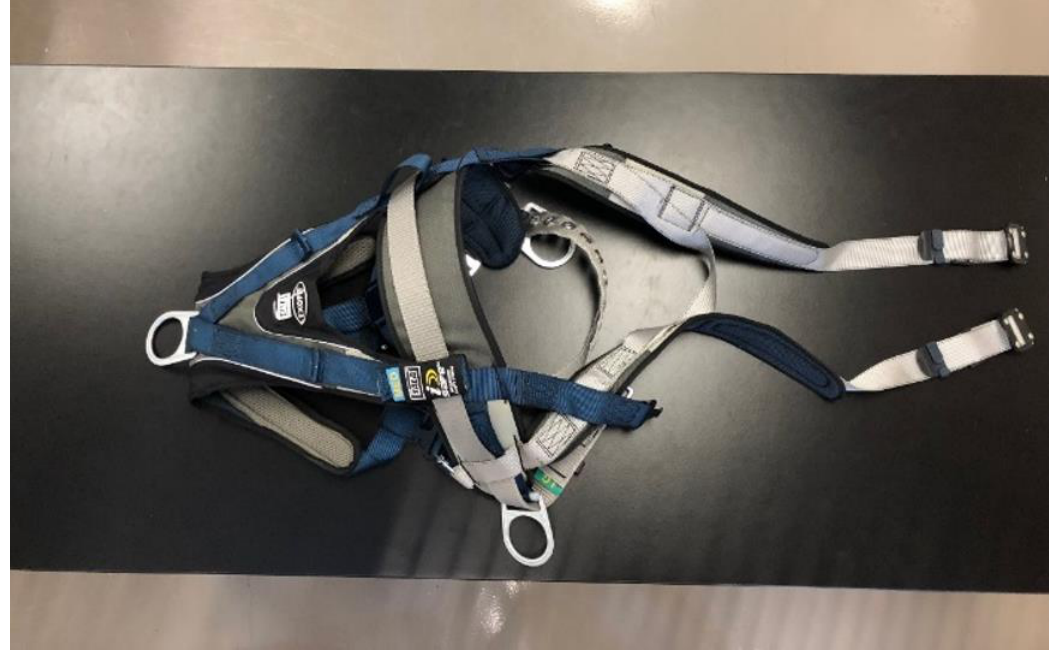
Figure 2. A harness placed on a table before the subject begins a donning process. Photo by Zachary Bunney [28].